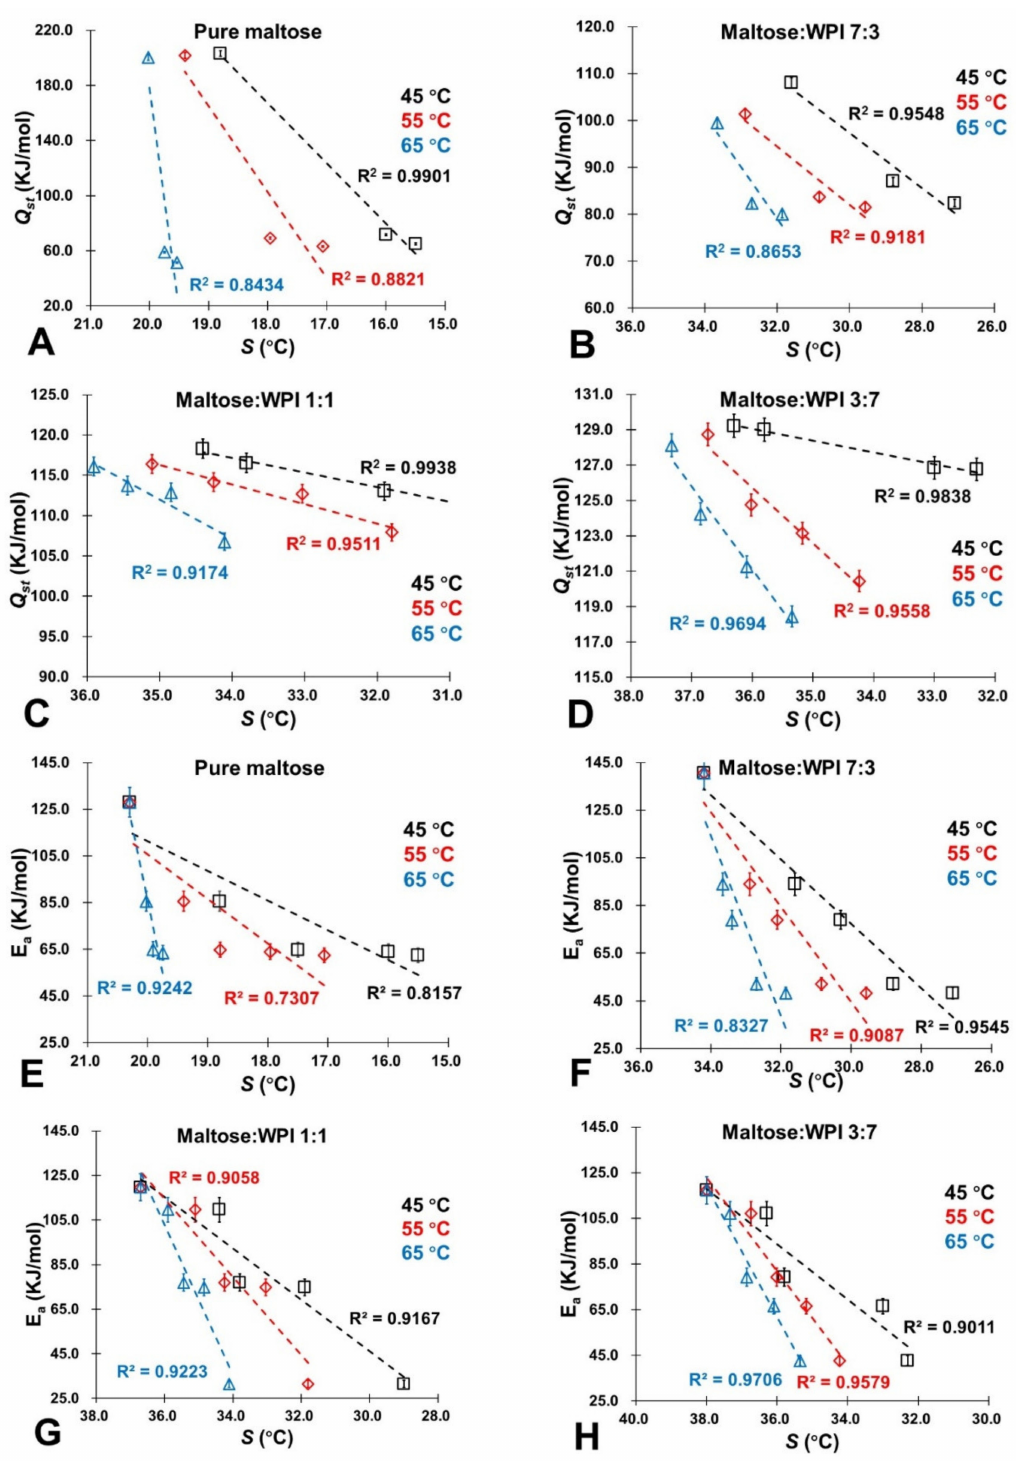
Figure 8. The relationship between Q st and E a associating with the S values of the studied samples at the studied storage conditions (0.11~0.76 a w ; 45 ◦ C~65 ◦ C). ( A ) Q st for pure maltose; ( B ) Q st for maltose:WPI 7:3; ( C ) Q st for maltose:WPI 1:1; ( D ) Q st for maltose:WPI 3:7; ( E ) E a for pure maltose; ( F ) E a for maltose:WPI 7:3; ( G ) E a for maltose:WPI 1:1; ( H ) E a for maltose:WPI